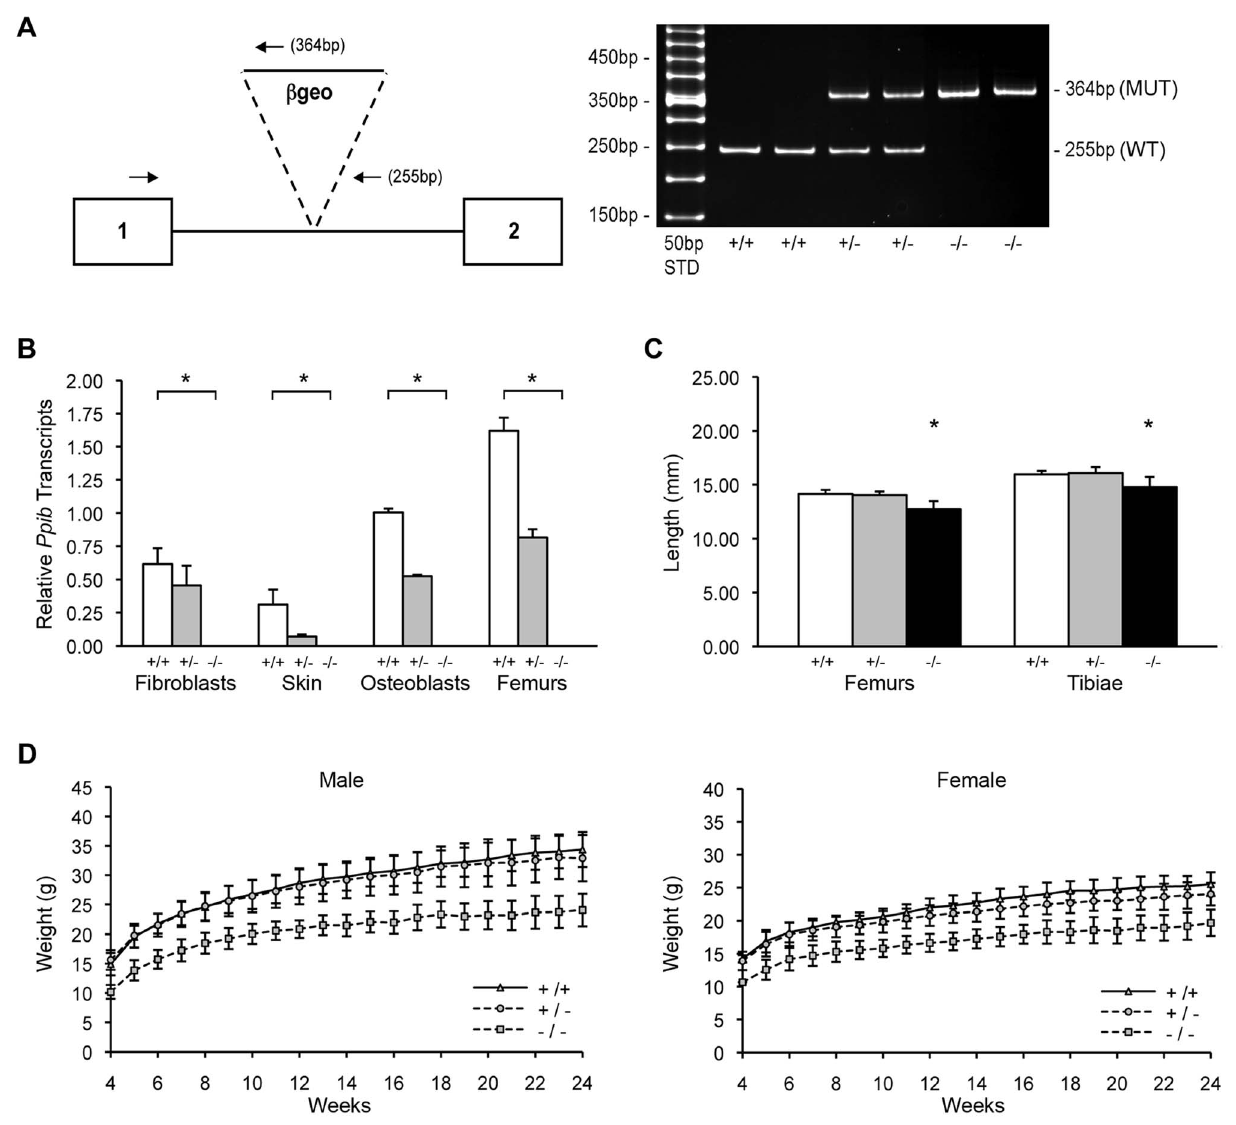
Figure 1. Generation of a murine model of Cyclophilin B deficiency. (A) Left , Diagram of knock-out allele containing b -geo reporter construct inserted into intron 1 of Ppib gene. Hemi-nested primers (arrows) for PCR-based genotyping selectively amplify the wild-type allele (255 bp) or the gene-trapped allele (364 bp). Right , Genotypes in offspring of matings between mice heterozygous for the gene-trapped allele are noted as wild-type ( + / + ), heterozygous ( + / 2 ) or homozygous ( 2 / 2 ). (B) Verification of Ppib expression by Real-time RT-PCR using total RNA isolated from primary cultures and tissues from newborns and 8-week mice, respectively. Values represent the average of two independent fibroblast and osteoblast cultures, and five independent dermal and femoral samples. (C) Lengths of femora and tibiae from 8 week-old wild-type ( + / + ), heterozygous ( + / 2 ) and homozygous ( 2 / 2 ) knock-out mice. Rhizomelia was not detected. (D) Growth curves of male and female mice from weaning (4 weeks) to 24 weeks of age.